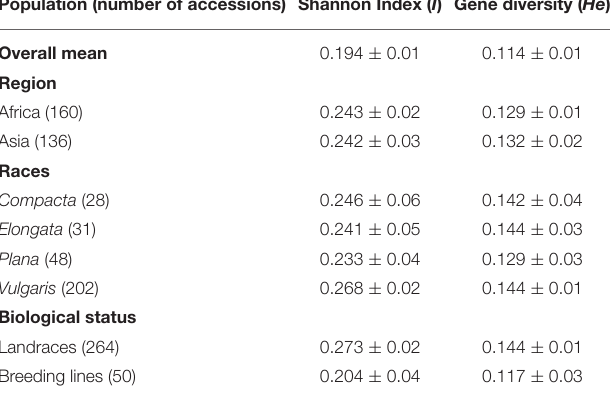
TABLE 2 | Pairwise estimates of modified Roger’s distance (MRD) (diagonal and upper diagonal) and Fst (lower diagonal) among the regions, races, and biological status of finger millet